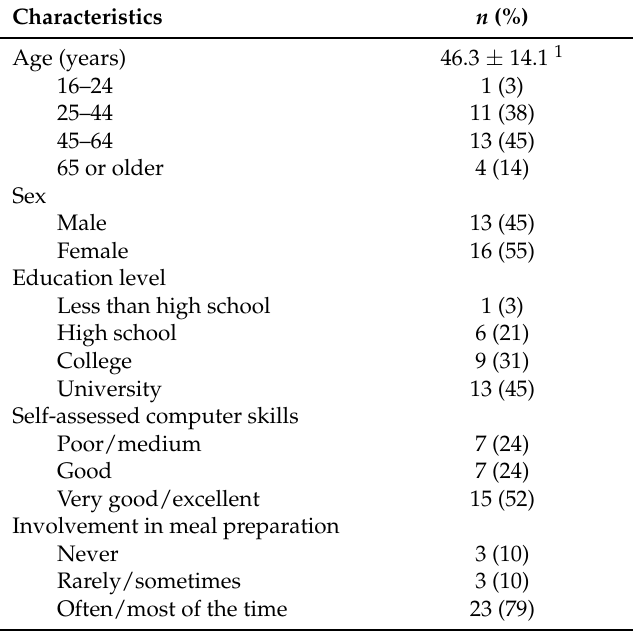
Table 2. Characteristics of the sample for the pre-test ( n =